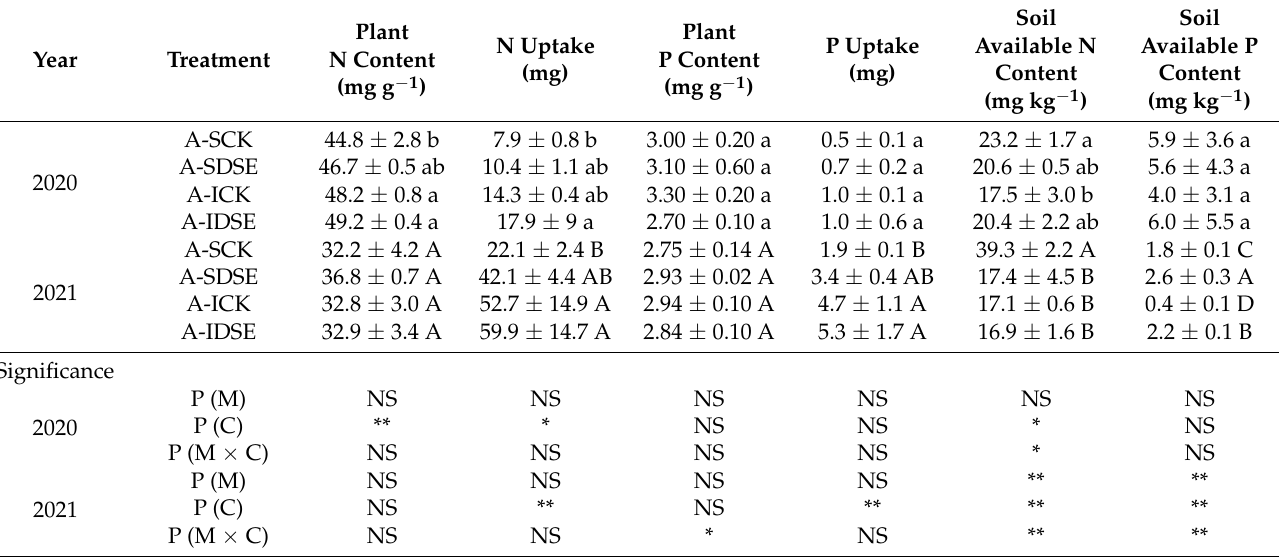
Table 4. Effects of the different treatments on nutrient uptake by